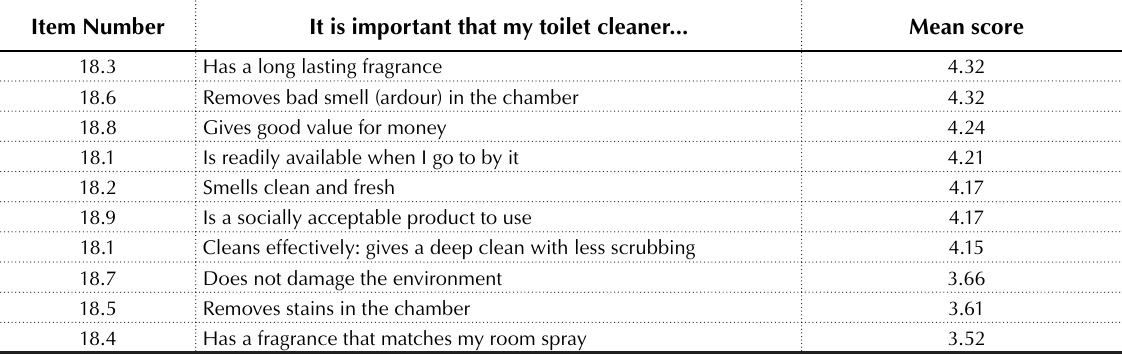
Table 7. Reasons for choosing a brand